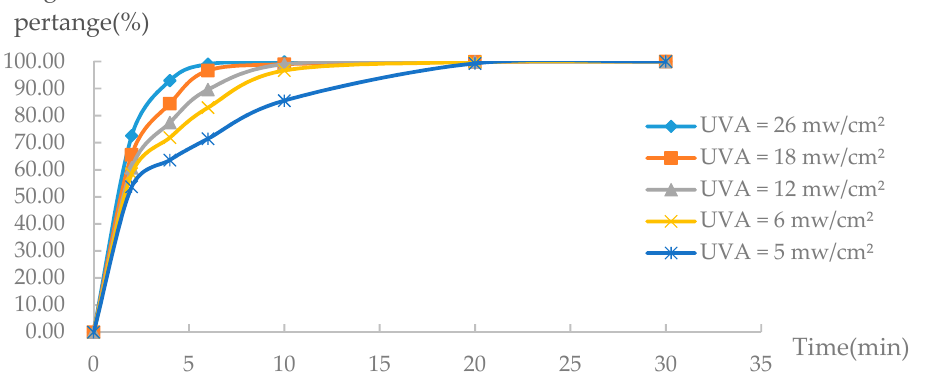
Figure Figure 7. The influence of different ultraviolet (UV) light intensities (5–26 mW/cm 2 ) on trimethoprim degradation.